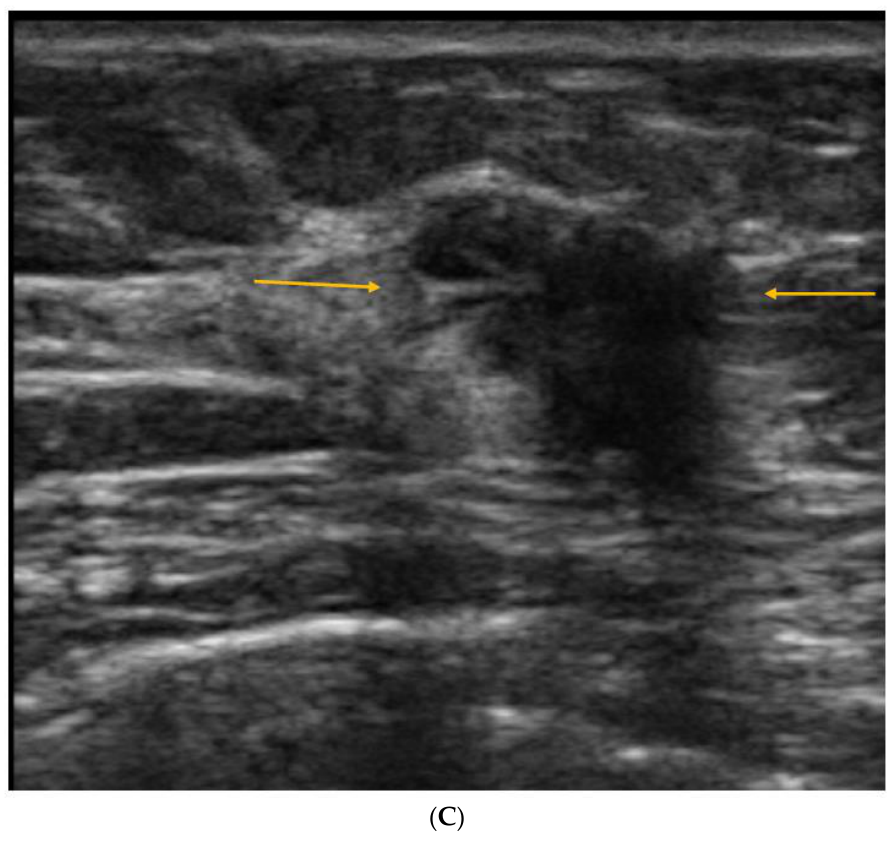
Figure 4. Illustration of DBT resolving an asymmetry seen at 2D screening mammography in the right retroareolar region, and unmasking a cancer in the right upper inner quadrant, not seen on the 2D mammogram. ( A ) This 58-year-old woman had a questionable asymmetry seen on her 2D screening mammogram on the right mediolateral oblique (MLO) view in the retroareolar region (arrow). ( B ) DBT was performed and the asymmetry was shown to be normal tissue, but a spiculated mass was seen in the right upper inner quadrant posteriorly (arrows). ( C ) A correlate was seen on US (arrows), for which histology showed invasive ductal carcinoma.